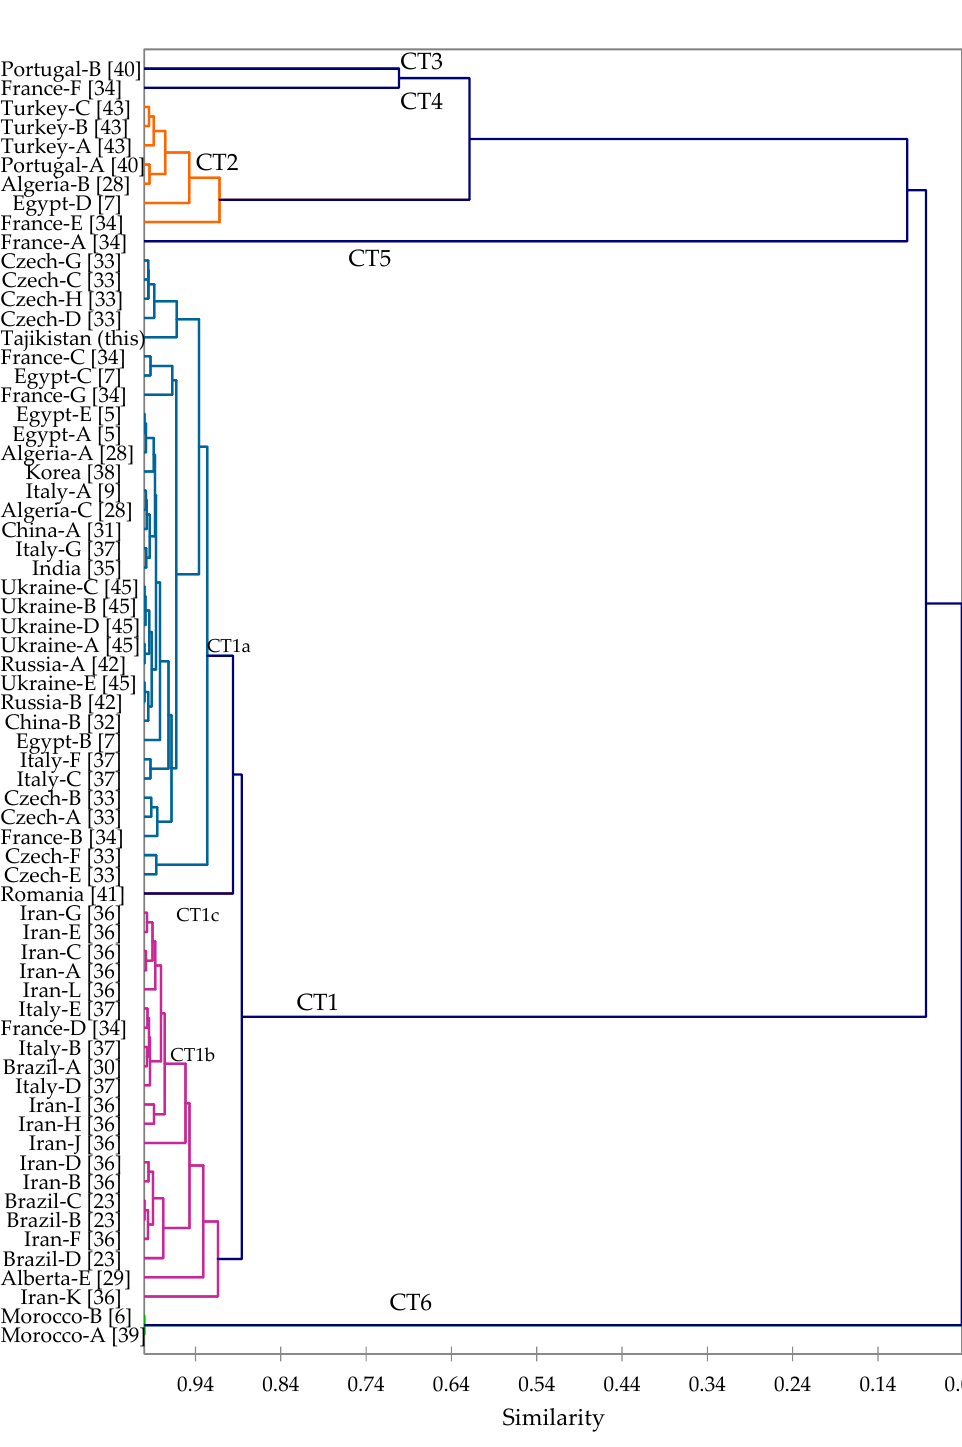
Figure 1. Dendrogram obtained from the agglomerative hierarchical cluster analysis of 68 Foeniculum vulgare essential oil compositions. (CT1) anethole ‐ rich chemotype, (CT1a) anethole chemotype, (CT1b) anethole/limonene chemotype, (CT1c) anethole/camphor chemotype, (CT2) estragole chemotype, (CT3) estragole/ α‐ phellandrene chemotype, (CT4) anethole/estragole/ α‐ pinene chemotype, (CT5) α‐ phellandrene chemotype, and (CT6) limonene/ β‐ pinene/myrcene chemotype. The concentration of 50% inhibition (IC 50 ) was the parameter used to compare the DPPH and ABTS radical scavenging activity. A lower IC 50 (for DPPH and ABTS) and higher FRAP